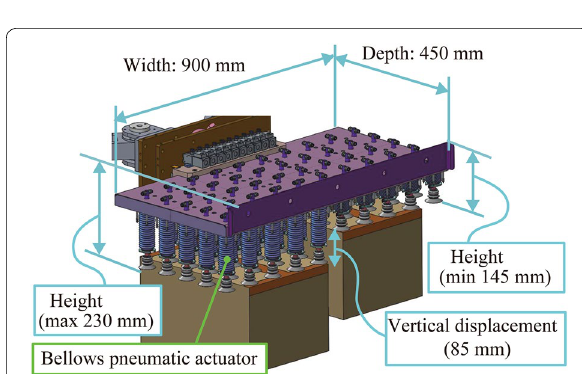
Fig. 21 Three-dimensional diagram of the developed end